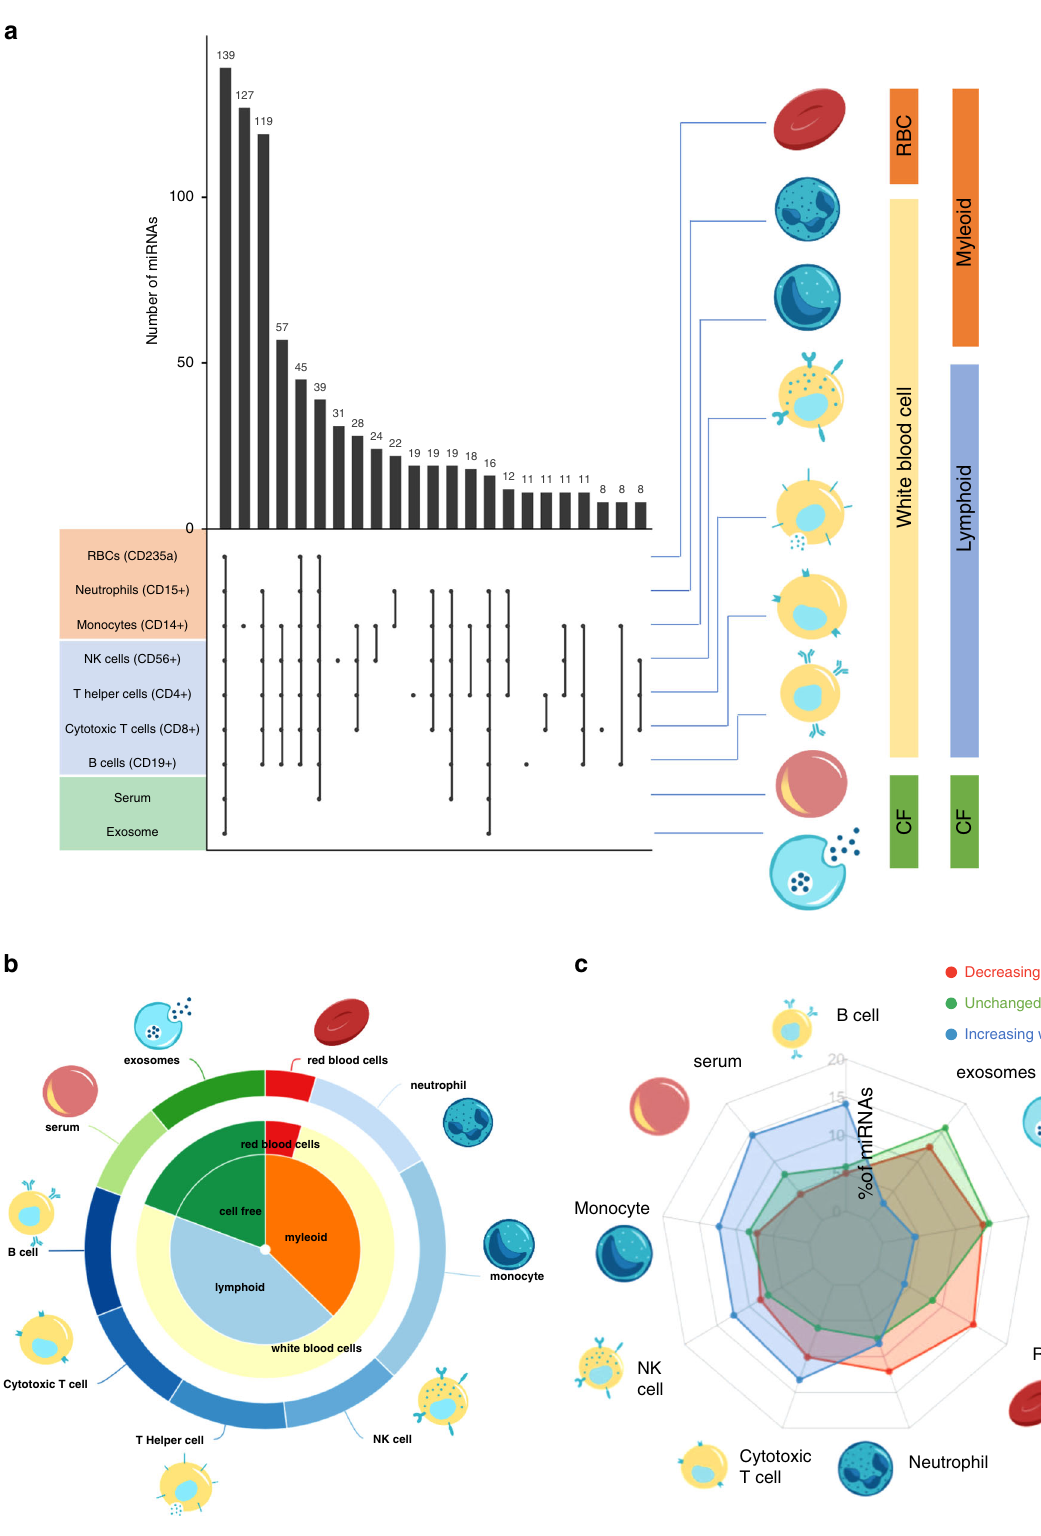
Fig. 5 Blood cell deconvolution. a The distribution of miRNAs in the different blood compounds. The rows are sorted by the blood compounds given on the right (RBC: red blood cell; CF: cell free), the columns are sorted according to a decreasing number of miRNAs. b Relative abundance of all miRNAs in the different blood compounds. c Distribution of miRNAs in cell types. The green distribution is the background and presents the relative composition of 1451 miRNAs in cluster 3. The blue distribution represents miRNAs increasing by age (cluster 4&5) and are enriched e.g., in B cells and serum. The red distribution represents miRNAs decreasing by age (cluster 1&2) and are enriched e.g., in neutrophils and